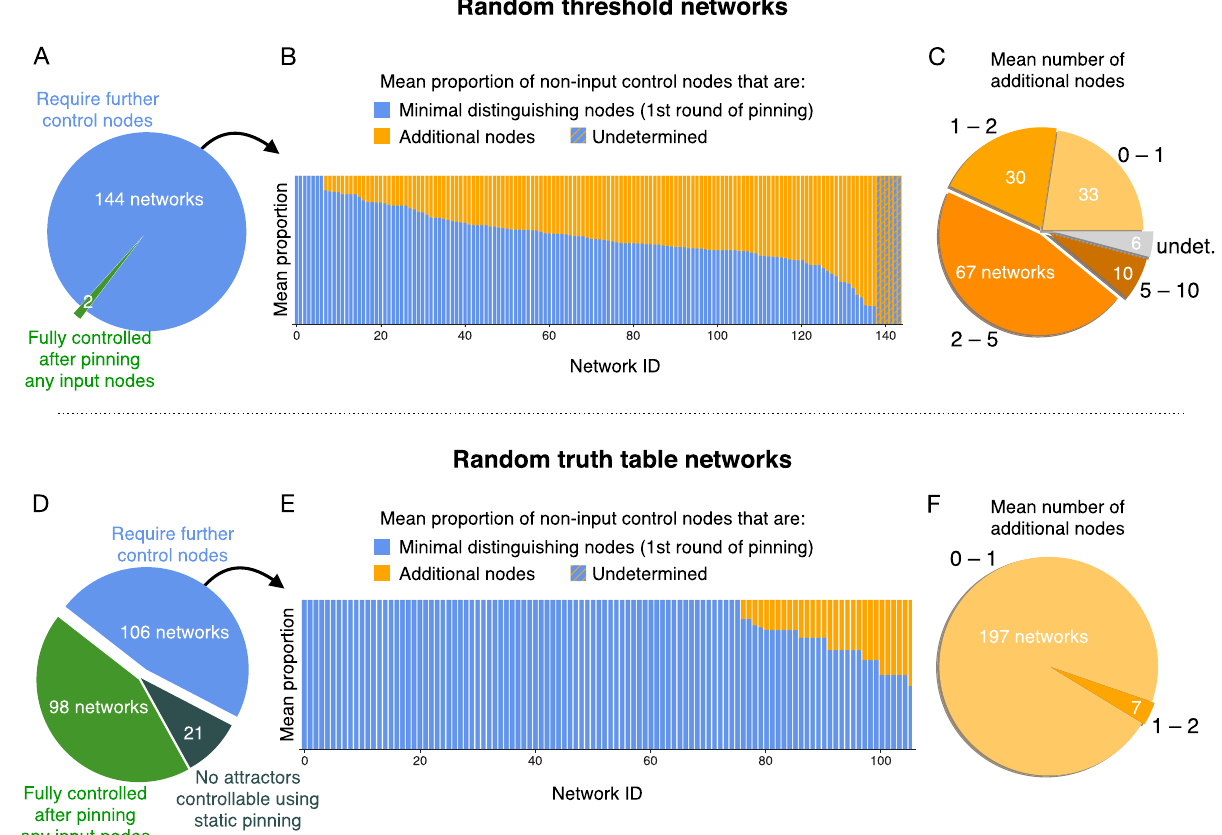
Fig. 10 Contributions to control kernel size for random networks. Compare to Fig. 4. For descriptions of random ensembles, see “ Methods ” . A – C Control kernel contributions for random threshold networks (including biased and balanced cases). These networks often require additional control nodes, but the relative number of additional nodes is still often smaller or comparable to the fi rst-order approximation given by the minimal distinguishing nodes. D – F Control kernel contributions for random truth table networks. These networks are typically easier to control. In D , we also see some networks for which all attractors are cycles and none are controllable using static